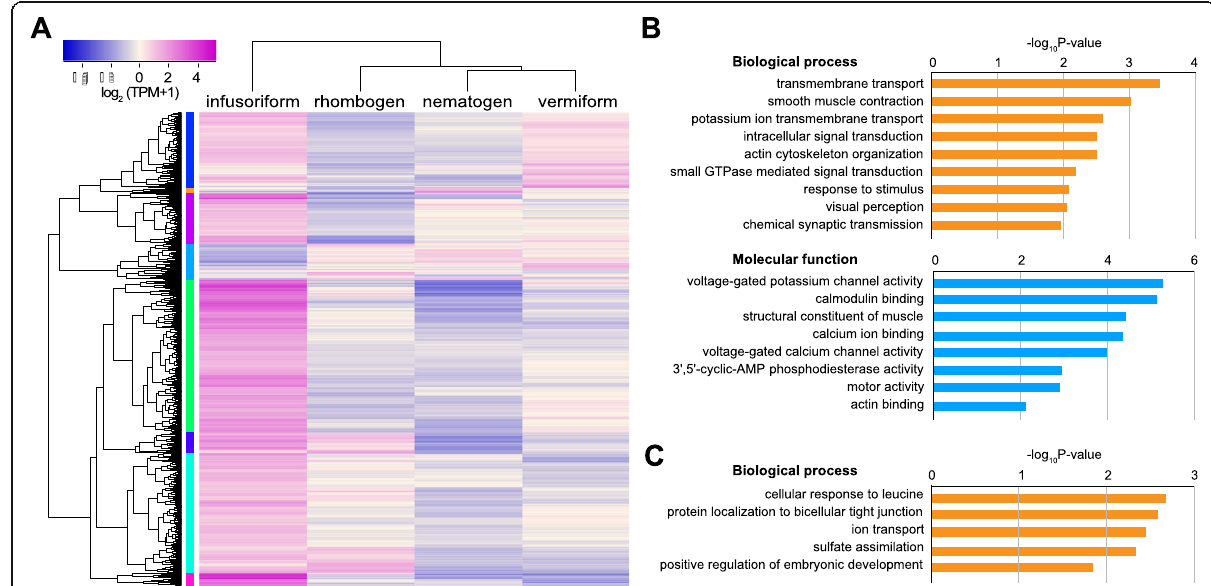
Fig. 3 Differential gene expression and over-represented GO terms in four life-cycle stages of Dicyema japonicum . a A heat map of expression levels of differentially expressed genes manifesting ≥ 4x differences among life-cycle stages. More than 80% of differentially expressed genes exhibit higher expression in infusoriform larvae. b Highly expressed infusoriform larval genes that exhibit over-representation for GO terms such as response to stimulus, chemical synaptic transmission, and ion channel activity, suggesting that dicyemids possess potential sensory functions. GO terms associated with mobility, such as motor activity and actin binding, suggest that some cilia of infusoriform larvae contribute to their swimming ability. c The over-represented GO terms of highly expressed genes in life cycle stages other than infusoriform larvae